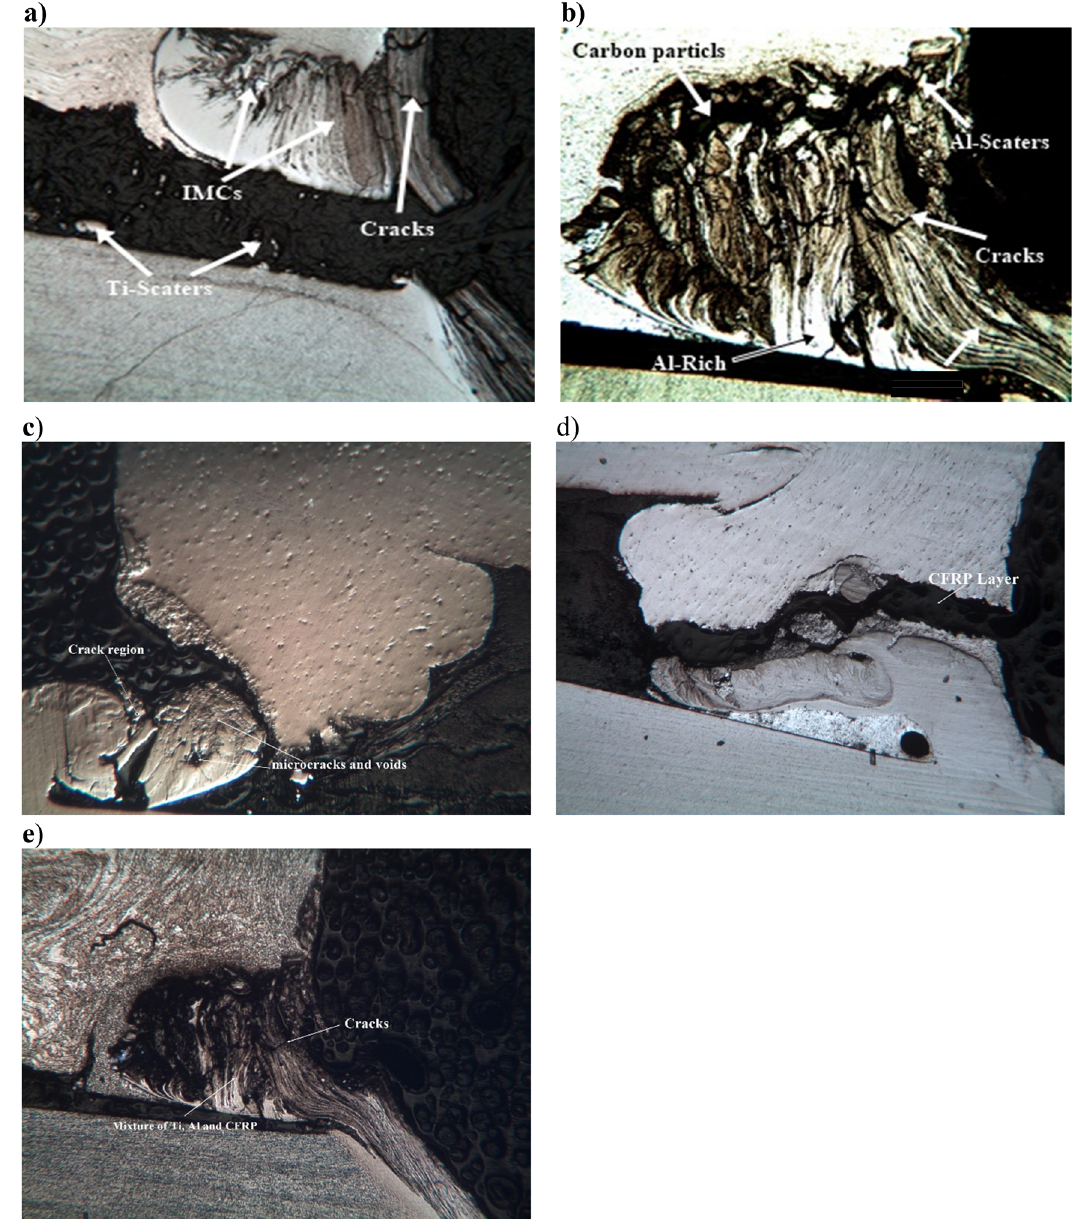
Figure 7: Optical microscopic results ( a ) 1,000 rpm 5 s, ( b ) 1,400 rpm 5 s, ( c ) 2,000 rpm 5 s, ( d ) 2,000 rpm 10 s, and ( e ) 1,400 rpm 10